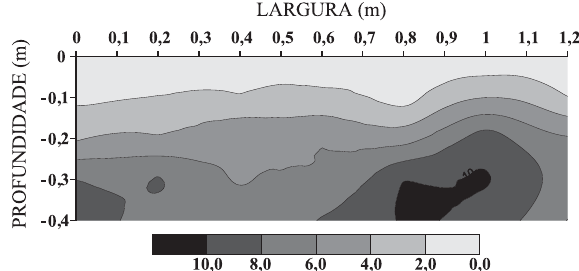
Figura 1. Mapa de isolinhas do atributo RP (MPa) no perfil do solo na área sem preparo.